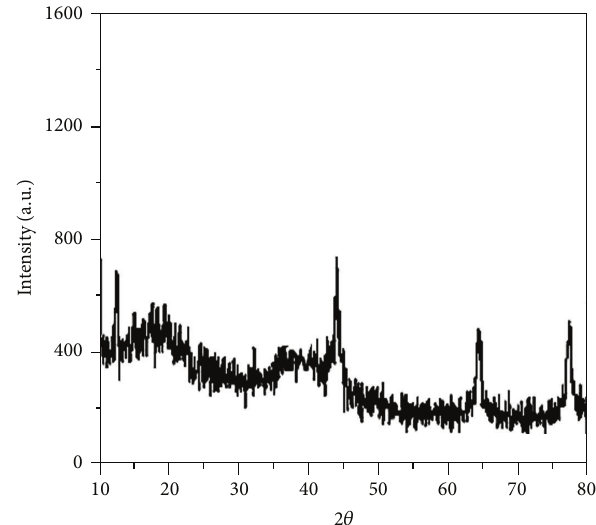
Figure 2: XRD pattern of PVP stabilized copper nanobuds exhibits 2 𝜃 values from 40 ∘ to 80 ∘ . The fcc structure of Cu nanobuds shows the average particle size 6.95